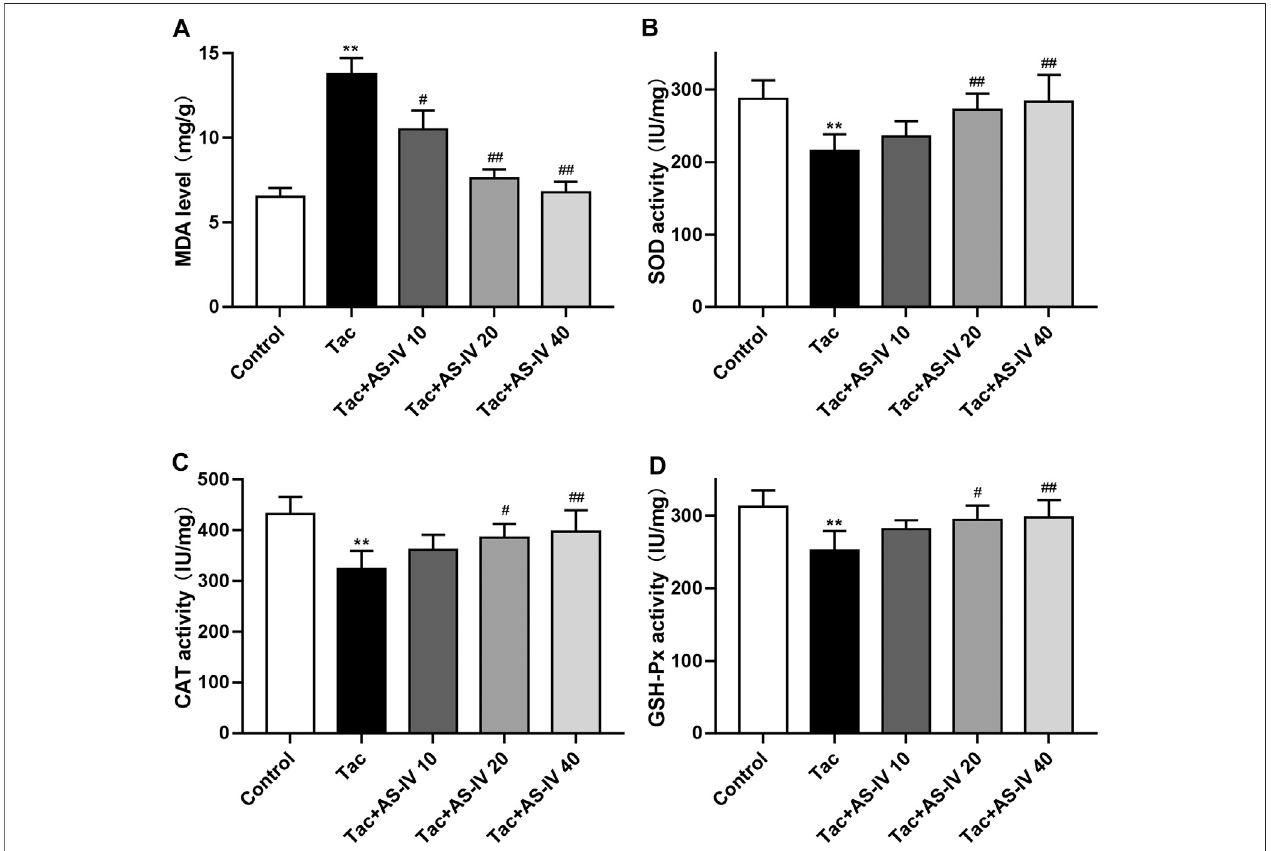
FIGURE2| AstragalosideIVattenuatesoxidativestressinducedbytacrolimus invivo ( n (cid:1) 8).Miceweretreatedwithtacrolimus ± AstragalosideIVfor4weeks,and then renal tissues were taken to evaluate the effects of Astragaloside IV on malondialdehyde (MDA) (A) , superoxidase dismutase (SOD) (B) , catalase (CAT) (C) and glutathione peroxidase (GSH-Px) (D) levels. ** p < 0.01 vs. the Control group; # p < 0.05 and ## p < 0.01 vs. the Tac group.